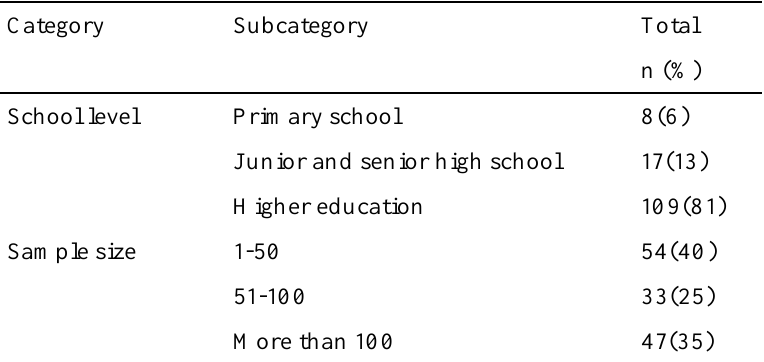
Descriptive Data for Peer Assessment